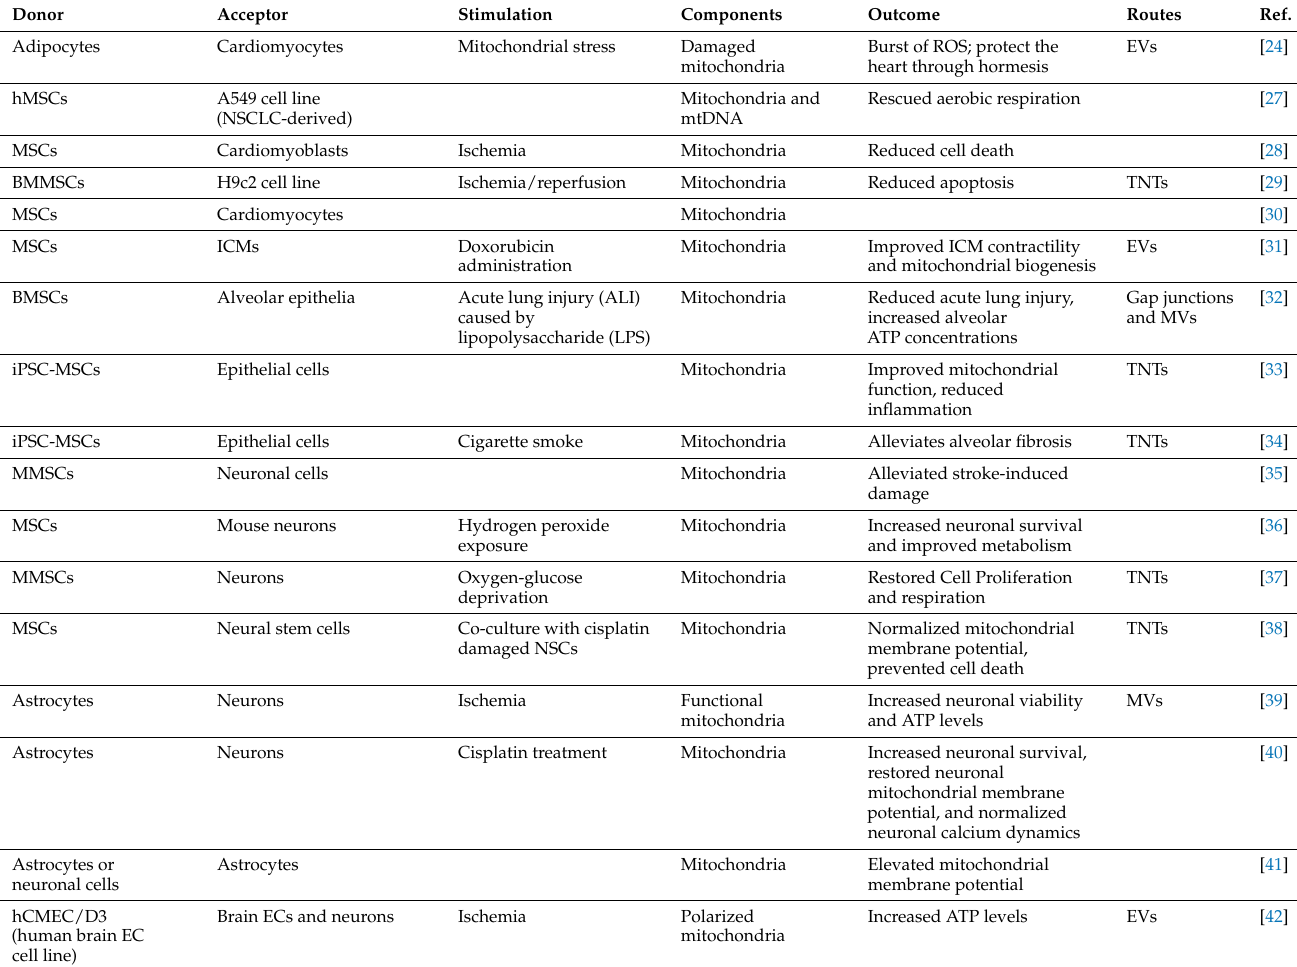
Table 1. Summary of the reports regarding mitochondrial release and/or transfer from various